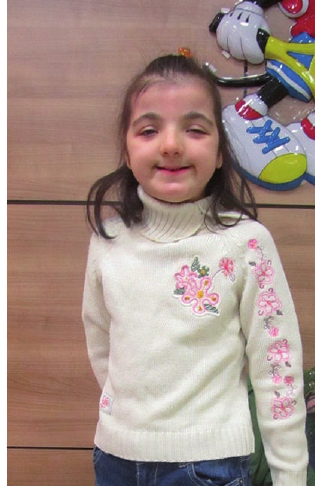
Figure 2: Facial characteristics include slanting palpebral fissures and beaked nose with nasal